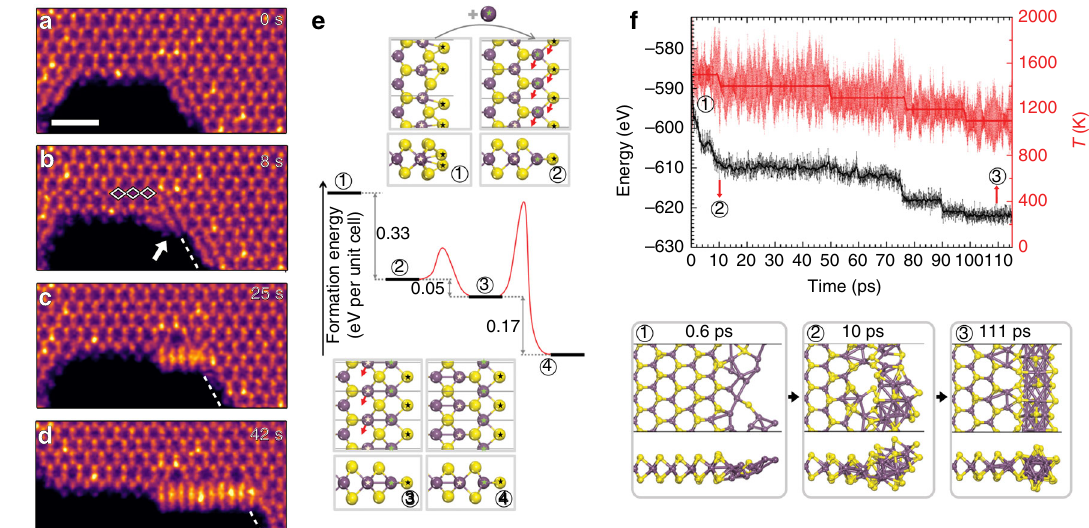
Fig. 3 Edge reconstruction dynamics. a – d Atomic resolution HAADF-STEM image frames showing typical states in the process of edge reconstruction from a ZZSe-Se to ZZSe-Mo-NW30. Scale bar is 1 nm. e Total energy (black) and energy barrier (red) associated with the four critical steps for ZZSe-Se ( a ) to ZZSe-GB4-Se ( b ) transformation, calculated at µ Mo = 1.2 eV. Top and front views of the relaxed structures of the four critical steps are displayed. f (Top) AIMD simulation of the edge energy (black) and system temperature (red) plotted over time with a time interval of 1 fs in the process of NW evolution. The black and red solid bold lines, representing energy and temperature respectively, are smoothed data to guide the eye. The energy of the system keeps decreasing, indicating increased stability. (Bottom) top and front view snapshots of edge structure at noted